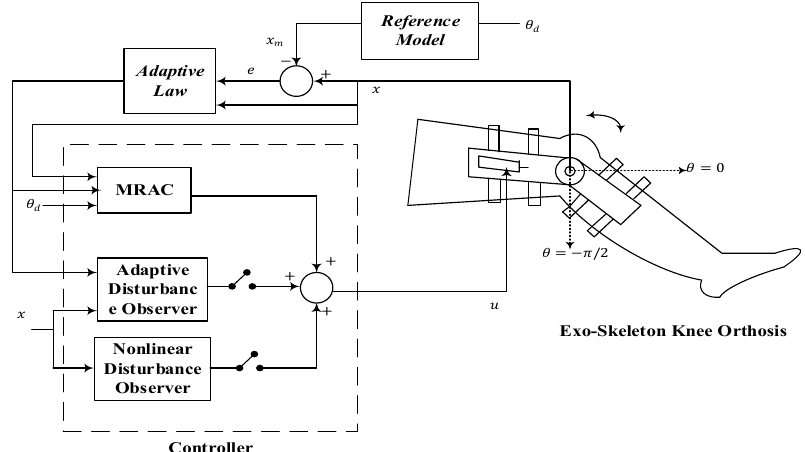
Figure 2. The schematic diagram of the MRAC with adaptive disturbance estimator and nonlinear disturbance observer controller to control robustly the angular position of the exoskeleton knee assisted system.